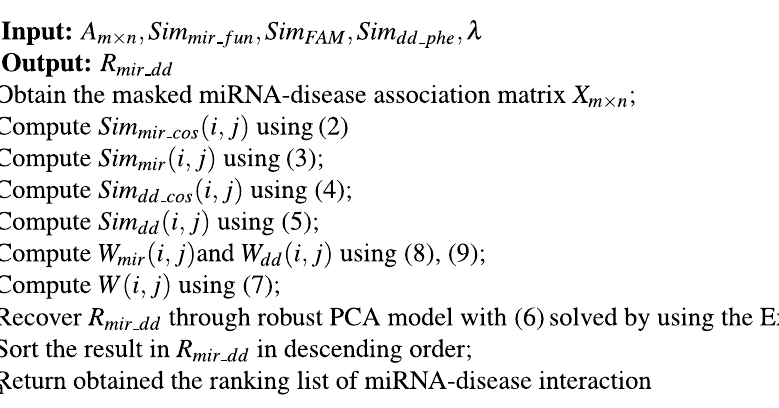
Algorithm 1 : ILRMR for miRNA-disease interaction predictio